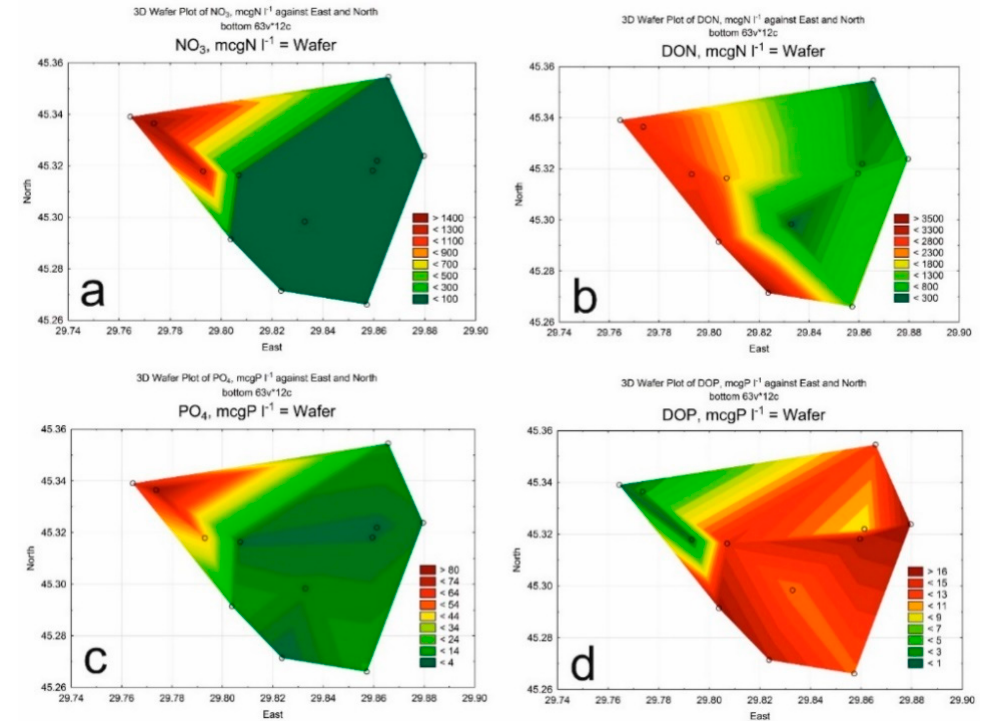
Figure 5. Statistically generated maps of nutrients from the bottom horizon in the Ukrainian part of the Danube nearshore area in August 2018: nitrates (NO 3 − ) ( a ); dissolved organic nitrogene (DON) ( b ); dissolved inorganic phosphorus (DIP = PO 4 3 − ) ( c ); dissolved organic phosphorus (DOP) ( d ).